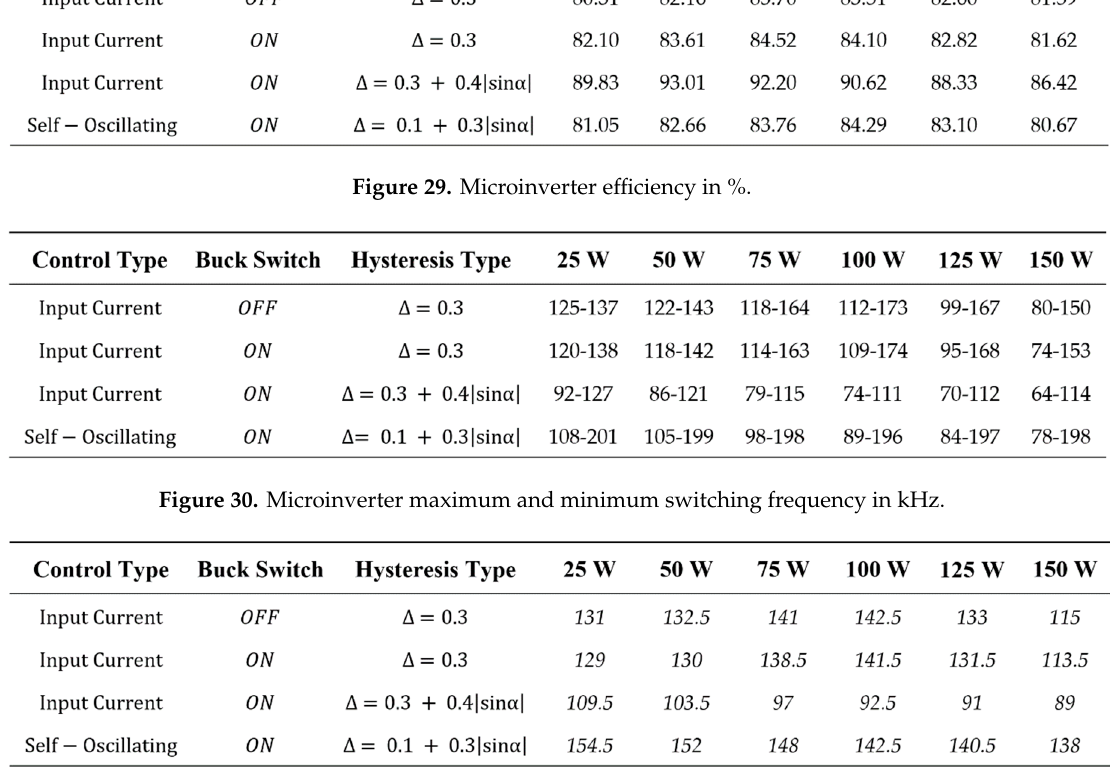
Figure 31. Microinverter average switching frequency in kHz.